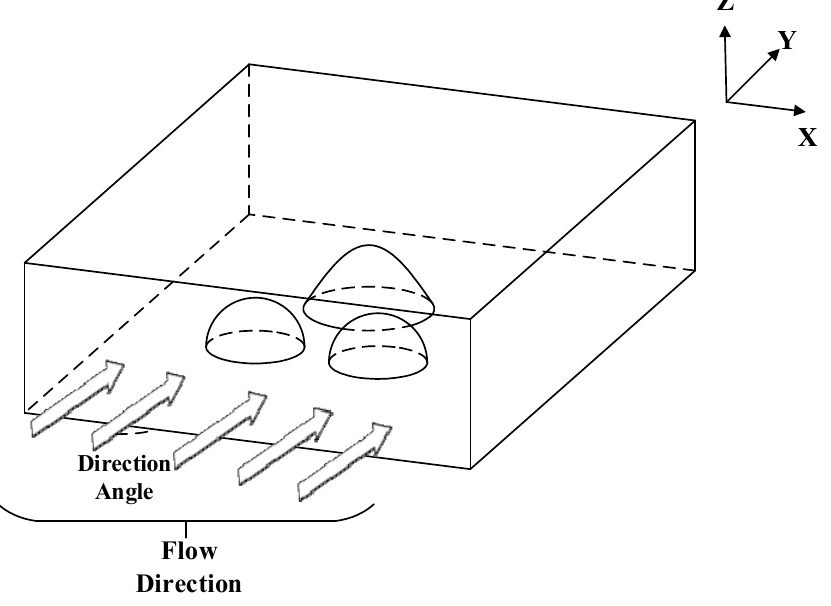
Figure 1. Geometric model for simulated wind field.